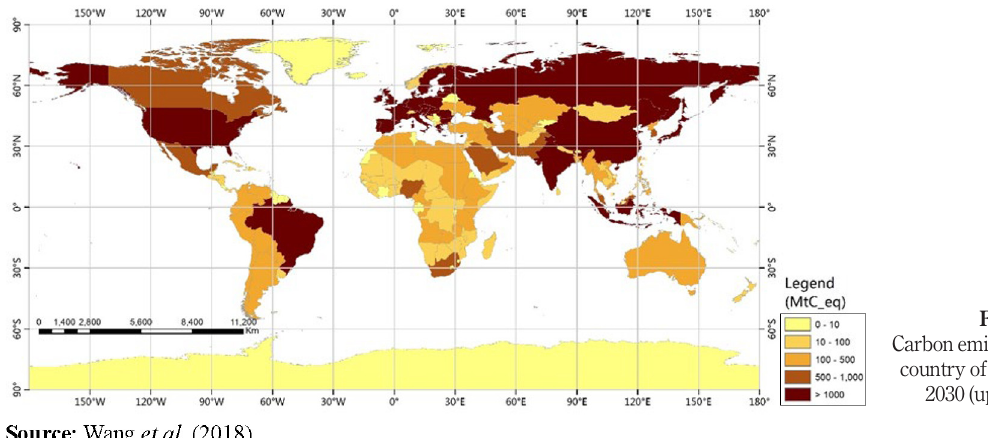
Figure 2. Carbon emissions by country of INDCs in 2030 (upper limit